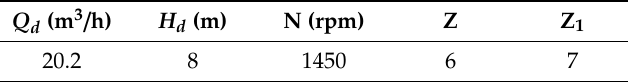
Table 1. Model pump design parameters.